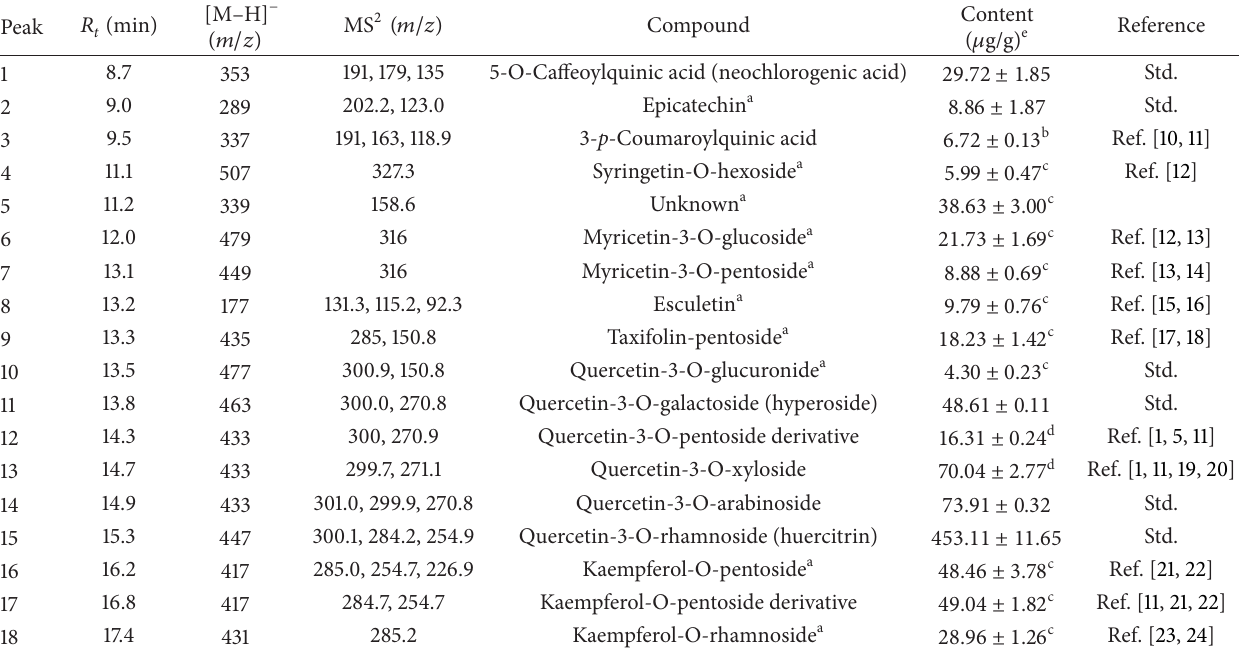
Table 1: The retention time, fragment ions, tentative identification, and quantification results of flavonoids and phenolic acids in Juglans regia L. Leaves.